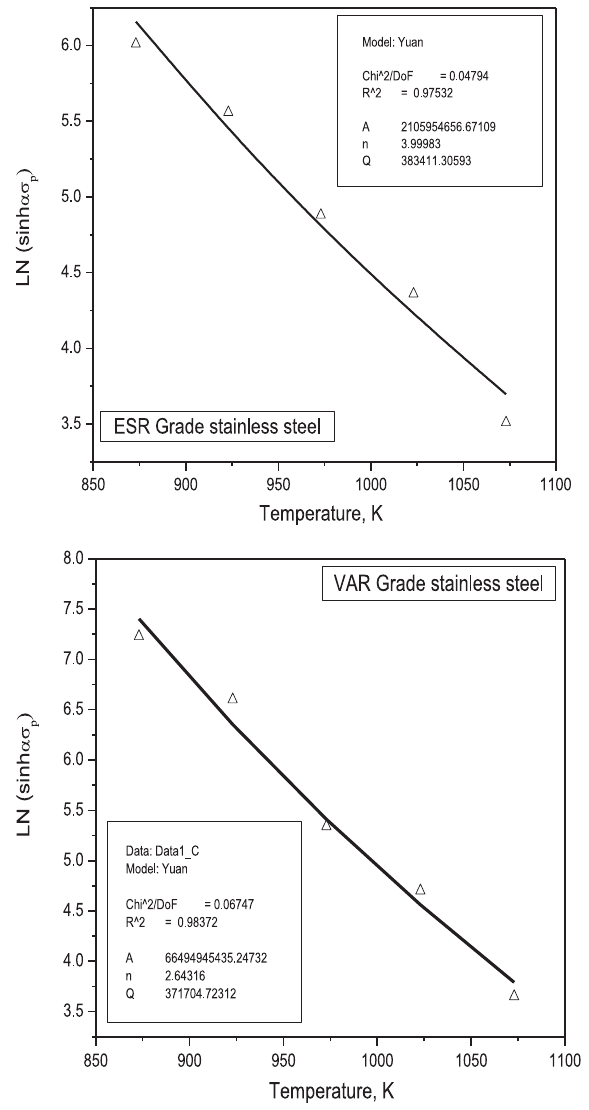
Fig. 6: Optical micrograph of ESR grade SS; (a) 20% coldworked condition and (b) after tensile testing at 1023